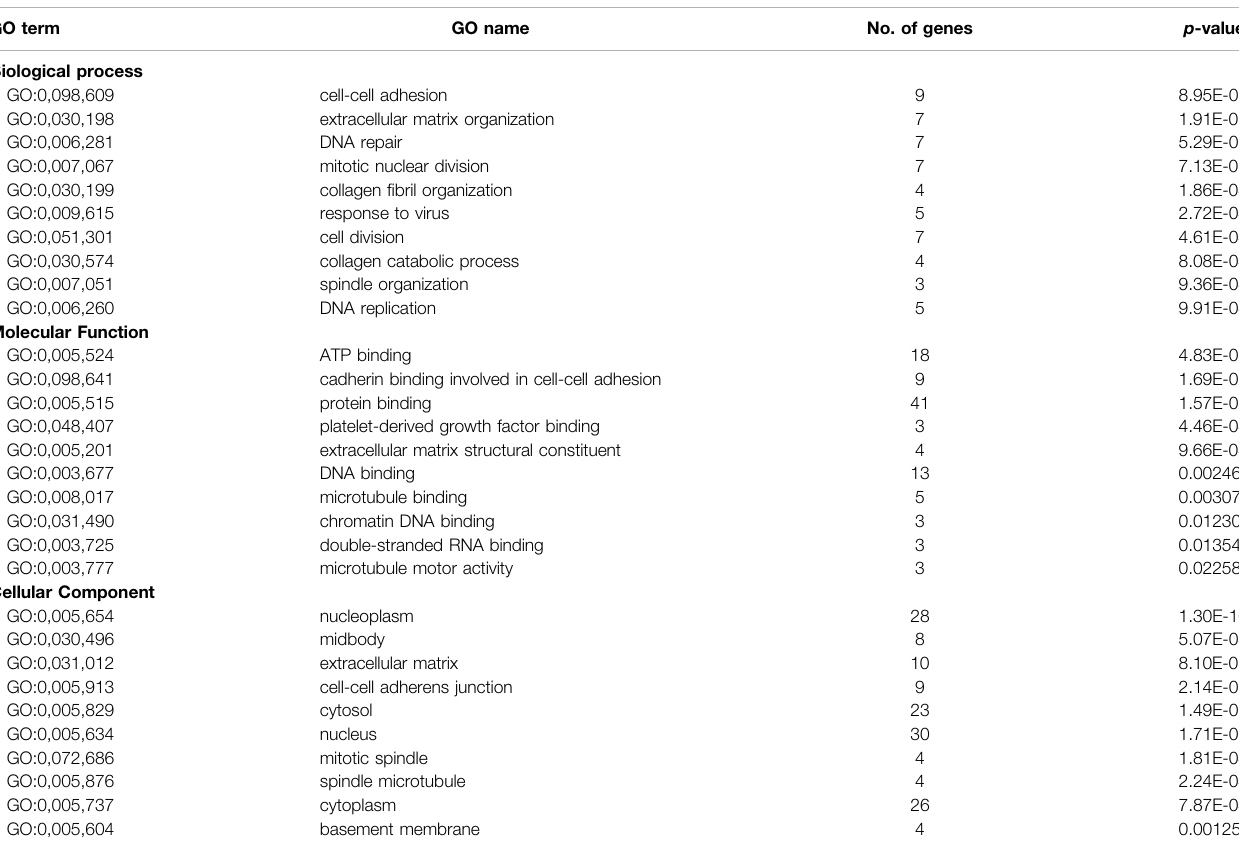
TABLE 5 | Top 30 GO terms for the top 50 hub genes from the PPI networks of the host genes of the DE circRNAs. GO term GO name No. of genes p